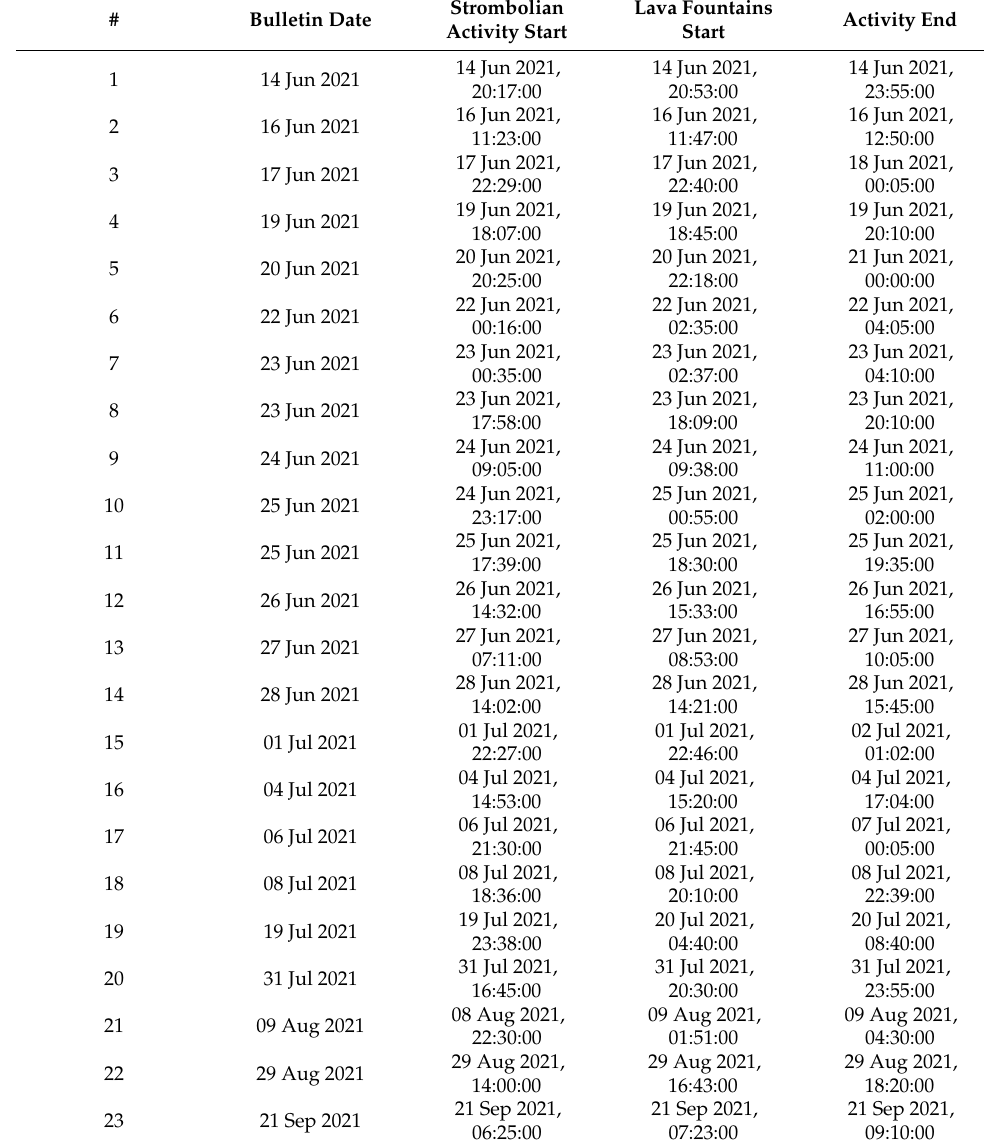
Table 2. List of the analysed explosive eruptive episodes that occurred at the SEC between June and September 2021. The timing of the onset and end of the Strombolian activity and lava fountains is reported on the basis of direct observation of visible and thermal cameras managed by the INGV-OE and volcano monitoring bulletins and